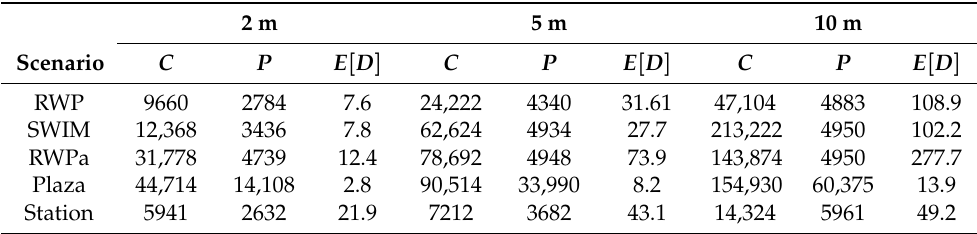
Table 2. The number of contacts, pair of individuals contacted and the accumulated average duration for the different scenarios and considering different distances. 2 m 5 m 10